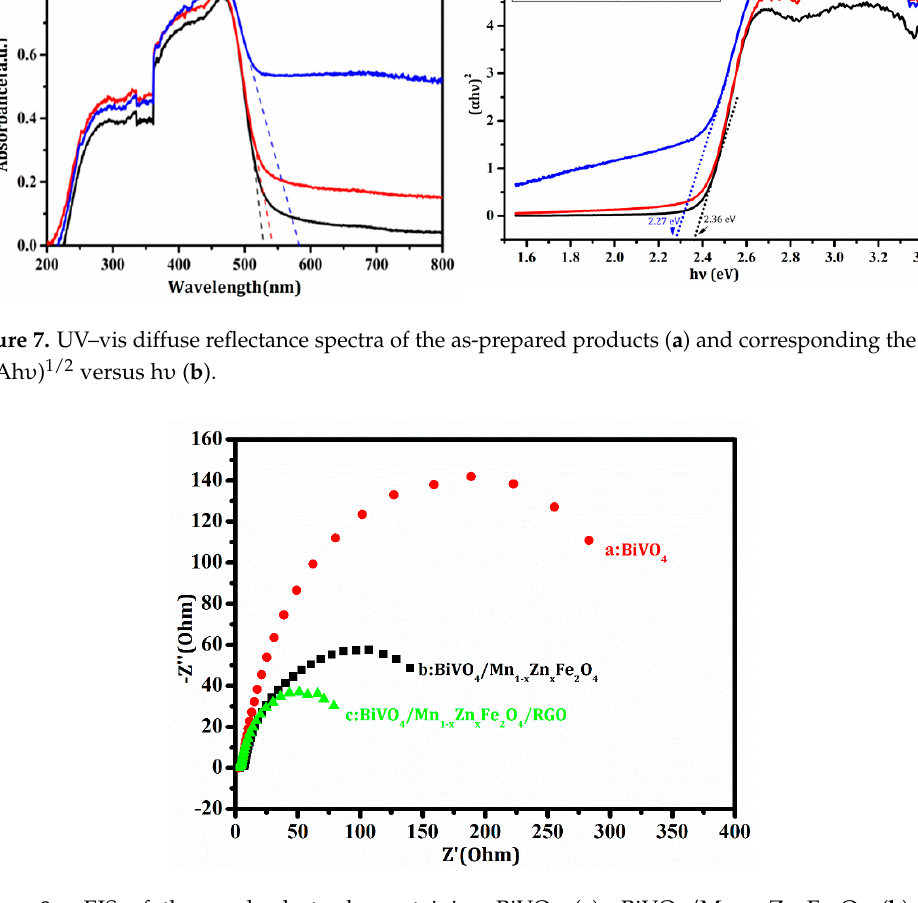
Figure 8. EIS of the work electrode containing BiVO 4 ( a ); BiVO 4 /Mn 1-x Zn x Fe 2 O 4 ( b ) and BiVO 4 /Mn 1- x Zn x Fe 2 O 4 /RGO ( c ).